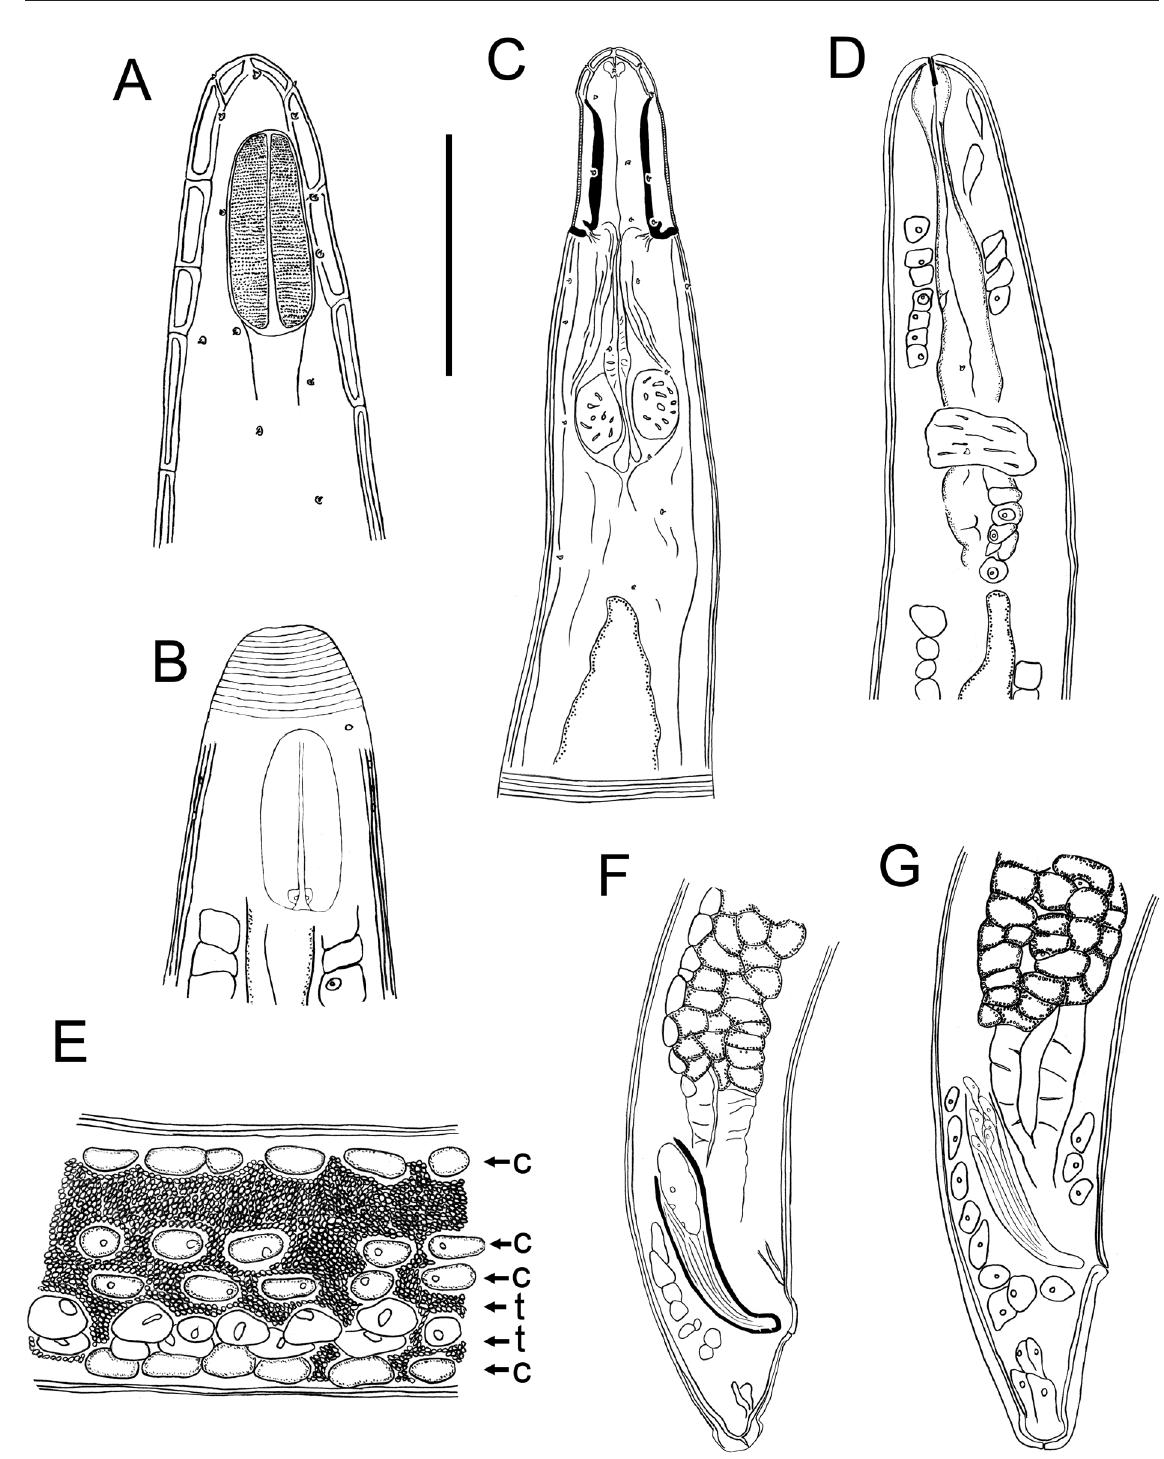
Fig. 1. Rhaptothyreus typicus Hope & Murphy, 1969. Line drawings. A . Lateral view of male head. B . Lateral view of moulting juvenile head, with details of surface striations on outer cuticle and outline of amphid under moulting cuticle. C . Anterior body region of male. D . Anterior body region of juvenile. E . Lateral view of male mid-body region. F . Posterior body region of male. G . Posterior body region of juvenile. Arrows show the position of the chord (c) and turgescent cells (t). Scale bar: A–B = 50 µm, C–D = 75 µm, E = 60 µm, F–G = 70